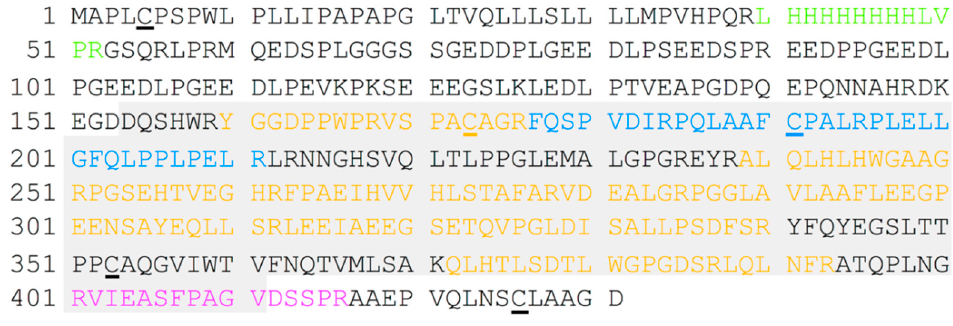
Figure 3. Sequence of Construct 1 used for crystallography and mass spectrometry. Shaded in gray is the extent of the CA domain visible in the crystal structure, while peptides from di ff erent samples are shown in di ff erent colors as follows: blue are the peptides only seen in the crystal; magenta is for the soluble portion; yellow are the peptides seen in both the soluble sample and the crystal; green is for the peptide containing the N-terminal His-tag that was only seen in the insoluble (precipitated) sample. Cys residues in the expression sequence are